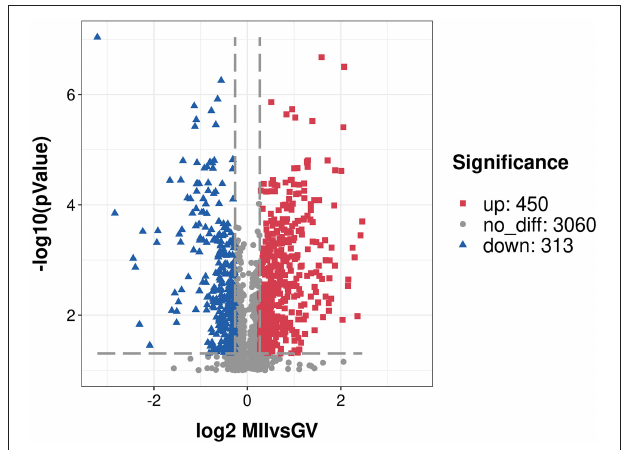
FIGURE 1 | A volcano plot of differentially expressed proteins. Proteins with fold change of ≥ 1.20 or ≤ 0.83 and P < 0.05 were considered statistically significant. Red blocks indicate significant over-expressed proteins, blue triangles indicate significant under-expressed proteins, while gray circles indicate proteins without differences. The X-axis represents fold change, Y-axis means P